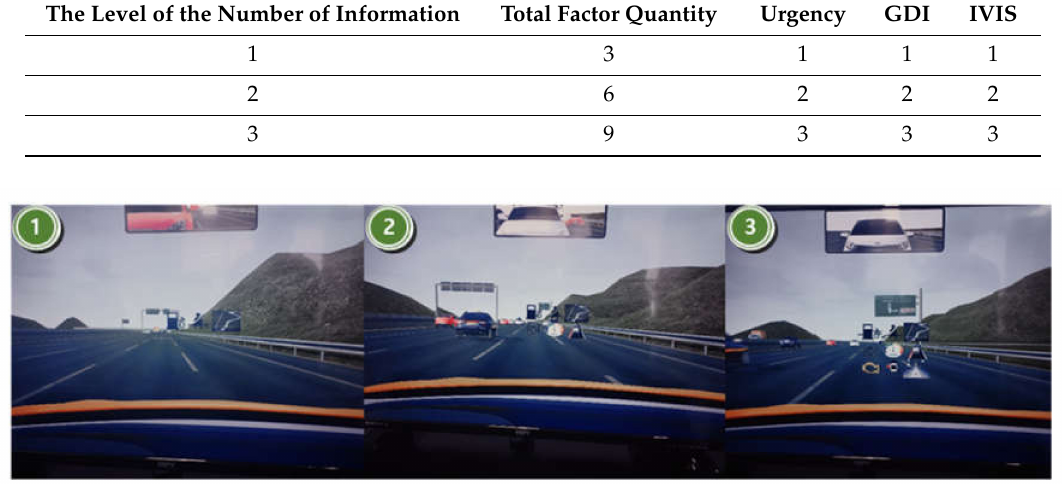
Figure 6. Three levels of